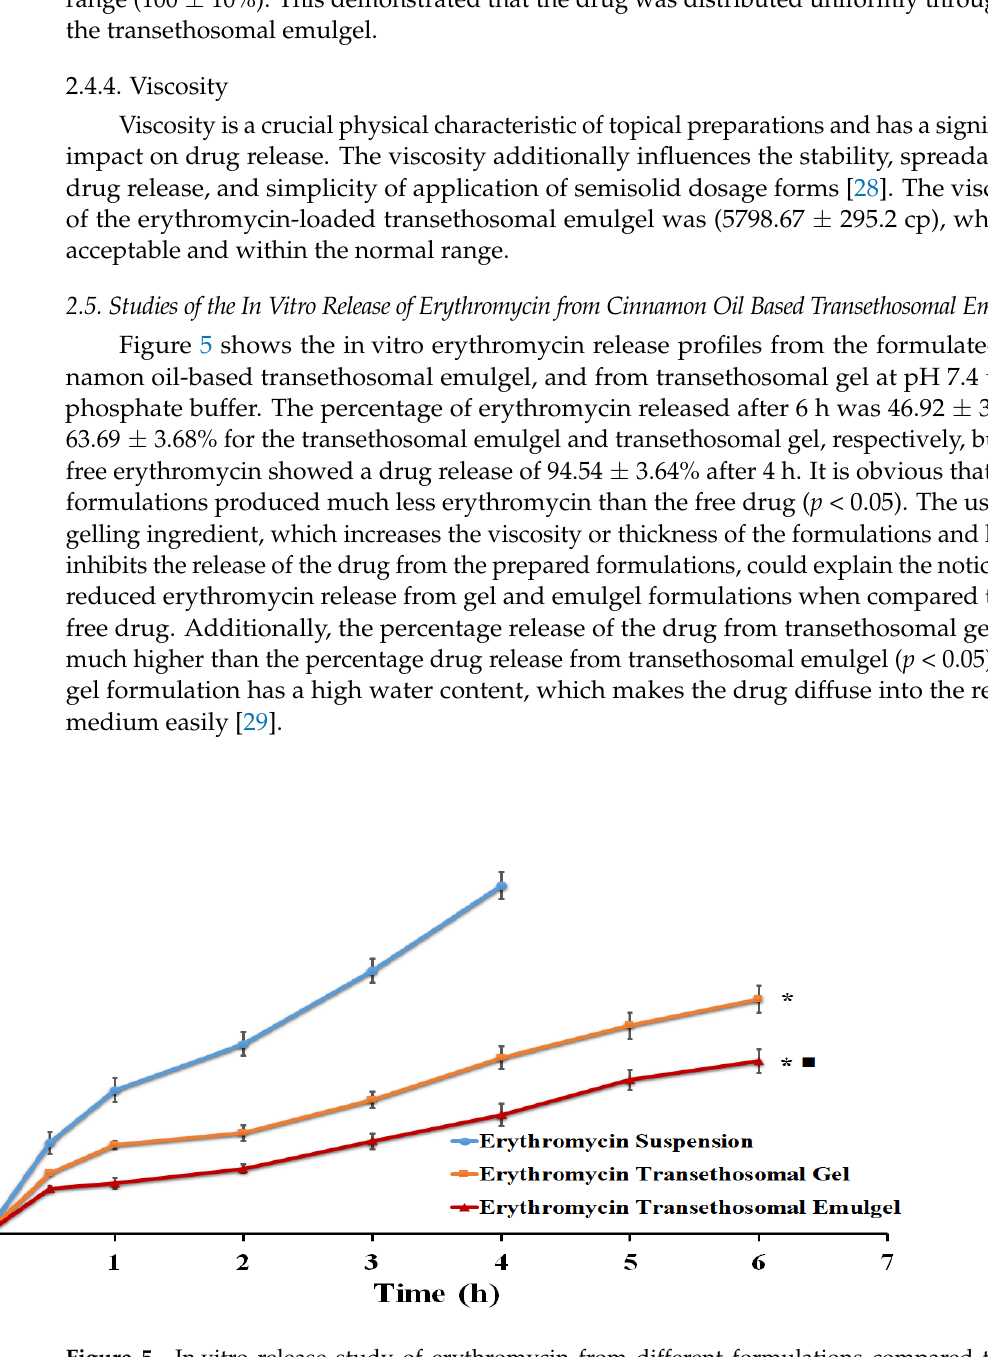
Figure 5. In vitro release study of erythromycin from different formulations compared to erythro- mycin suspension. Results are represented as the mean ± SD of three runs. * p < 0.05 compared to erythromycin suspension; and ■ p < 0.05 compared to erythromycin transethosomal